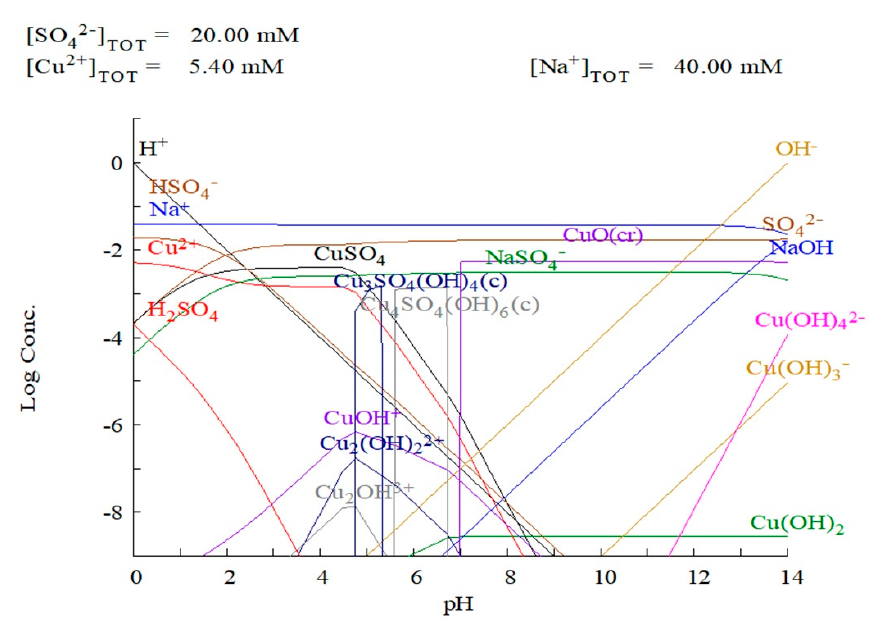
Figure 7. Chemical speciation diagram for copper, generated from Hydra-Medusa software.